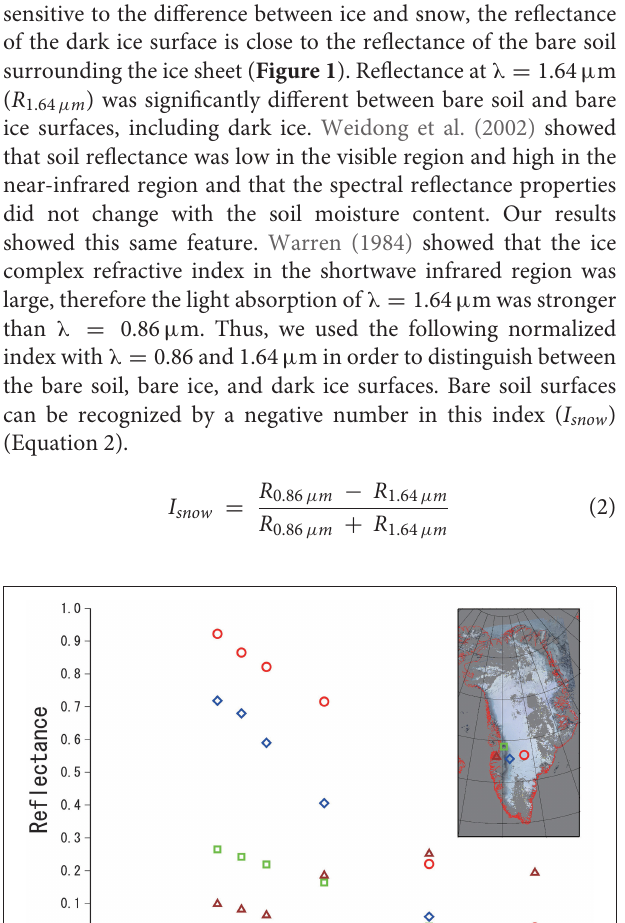
Frontiers in Earth Science |